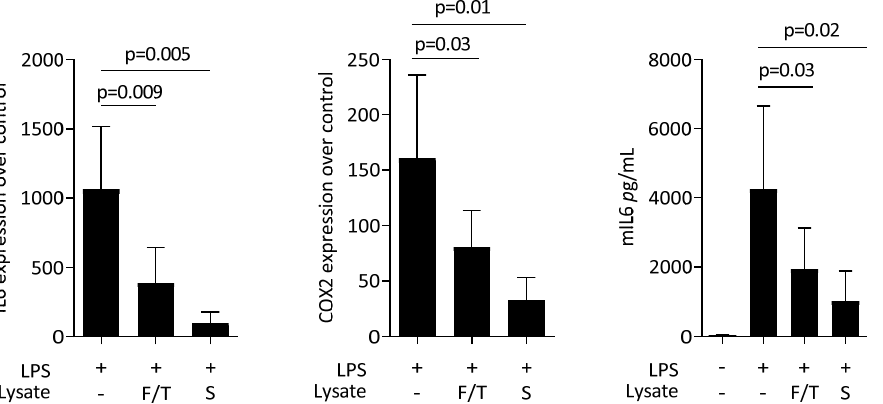
Figure 1. ST2 lysates reduce lipopolysaccharides (LPS)-induced M1 polarization of RAW 264.7 macrophages. RAW 264.7 macrophages were exposed to ST2 lysates prepared by freeze/thawing (F/T) and sonication (S) with LPS. Data show the x-fold changes of IL6 and COX2 gene expression and the release of IL6 protein into the supernatant. The expression changes were normalized to an unstimulated control. The bars represent the mean and standard deviation of five independent experiments. Statistical analyses were based on RM one-way ANOVA.